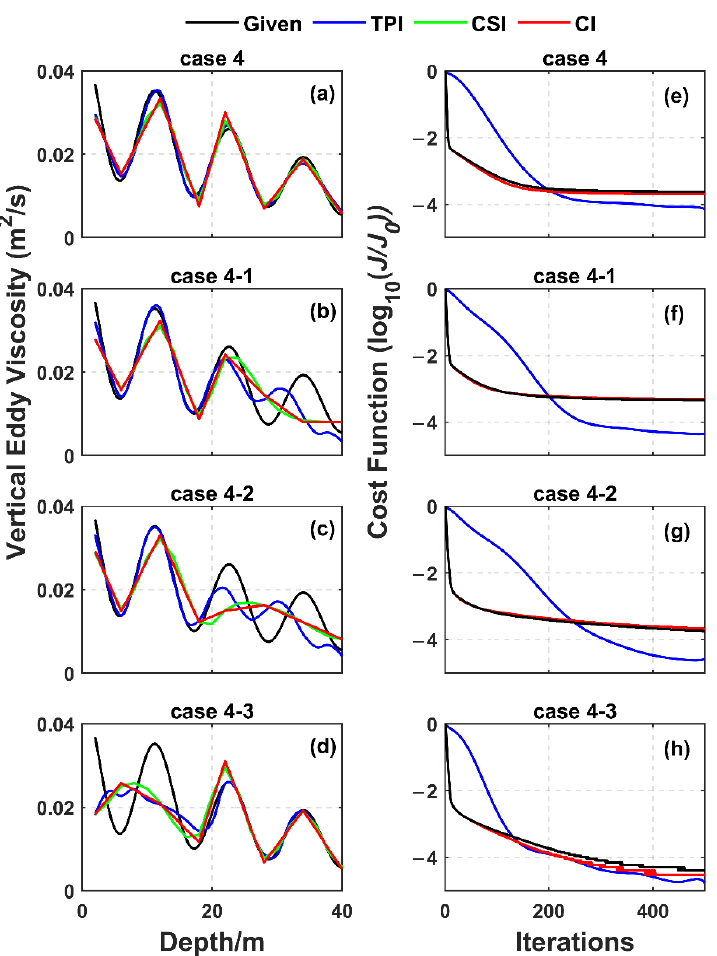
Figure 3. The prescribed and inversion distributions of the VEVCs after using different observation depths on the left. ( a – d ) correspond to Cases 4, 4-1, 4-2, and 4-3, respectively. On the right are the cost functions of the three schemes in Group 2. ( e – h ) correspond to Cases 4, 4-1, 4-2, and Case 4-3, respectively.